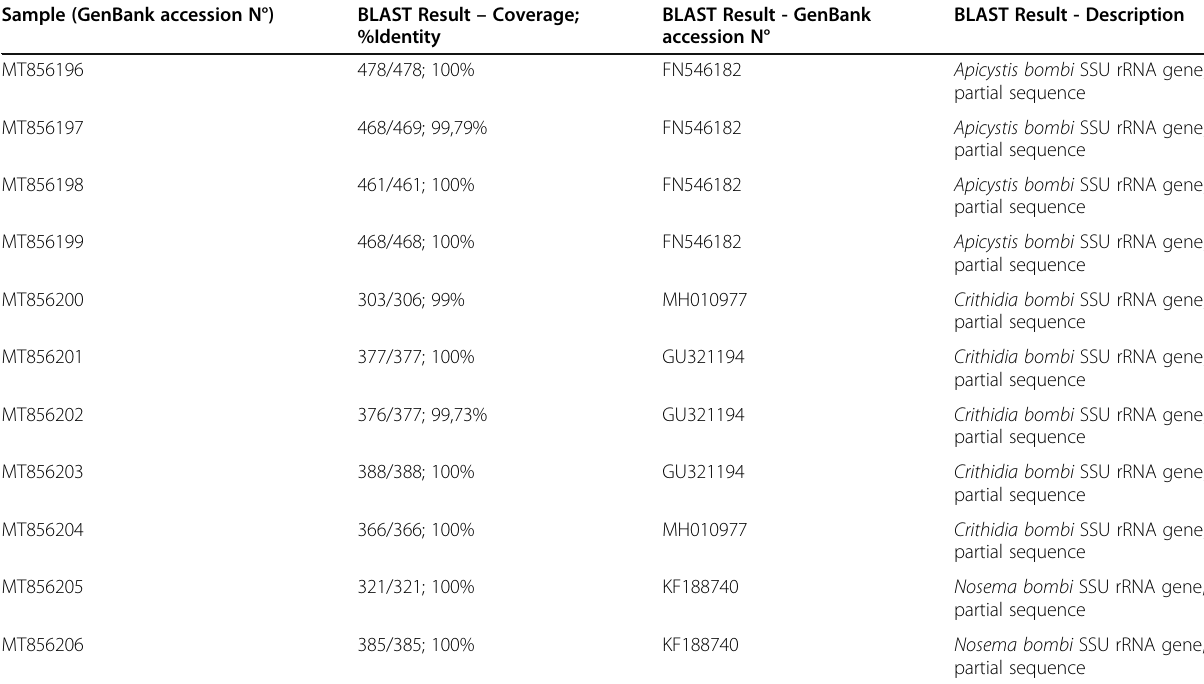
Table 3 BLASTn search results of parasite PCR products. The best alignment between the query sequence and the found sequence is shown in each case Sample (GenBank accession N°) BLAST Result – Coverage;